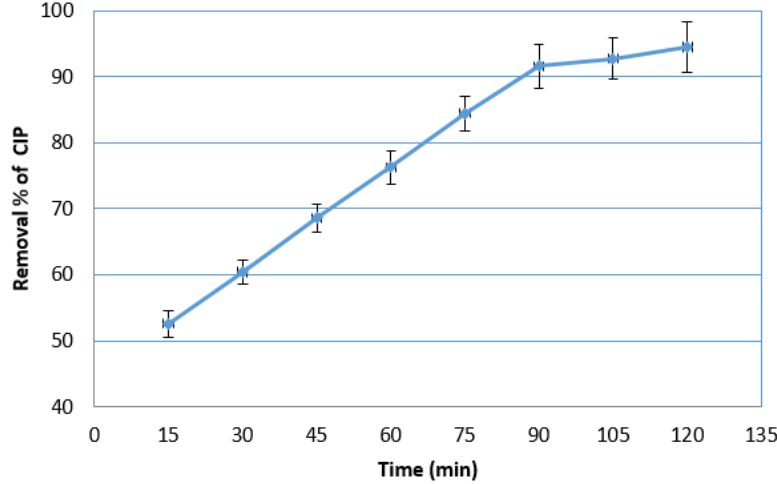
Figure 7. CIP removal percentage using 5 wt% N-doped TiO 2 after the coating process at initial concentration of CIP = 30 ppm, pH = 5, and feed flow rate = 0.4 L/min.